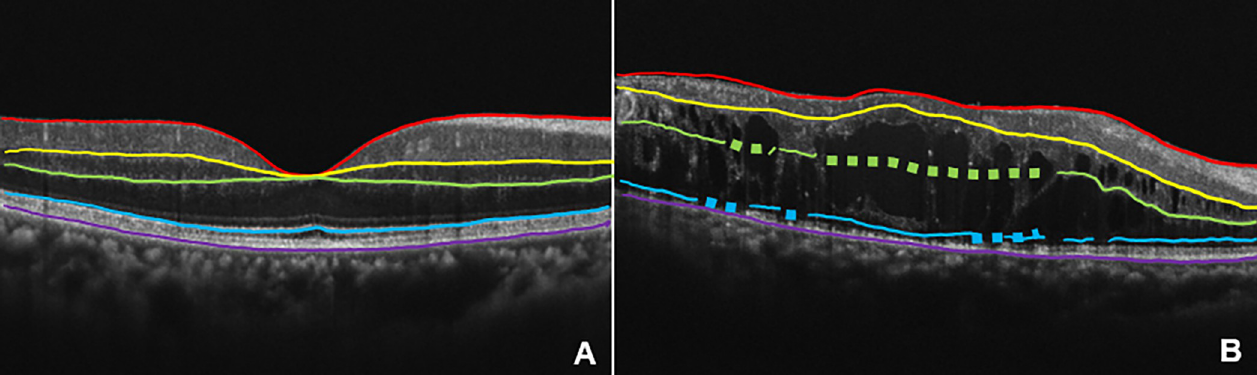
Fig 3. Example of segmentation using the ambiguity index. Normal eyes (A) and diabetic retinopathy (B). The boundary line of the layer was drawn using AI in this study. Because each boundary line is represented by a series of dots, there is an entropy value for each dot. The points where the value was high were delineated by a thick dotted line, and the points where the value was small were delineated by a thin solid line. Red; ILM; yellow, IPL/INL; green, OPL/ONL; blue, EZ; purple, RPE/BM.